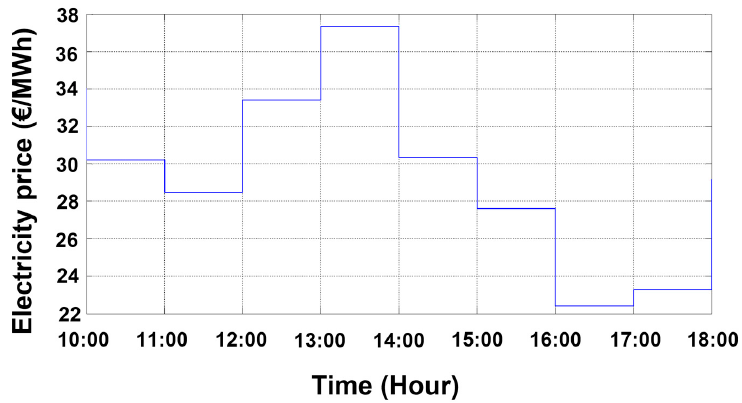
Figure 12. Electricity price hourly profile during the test period.